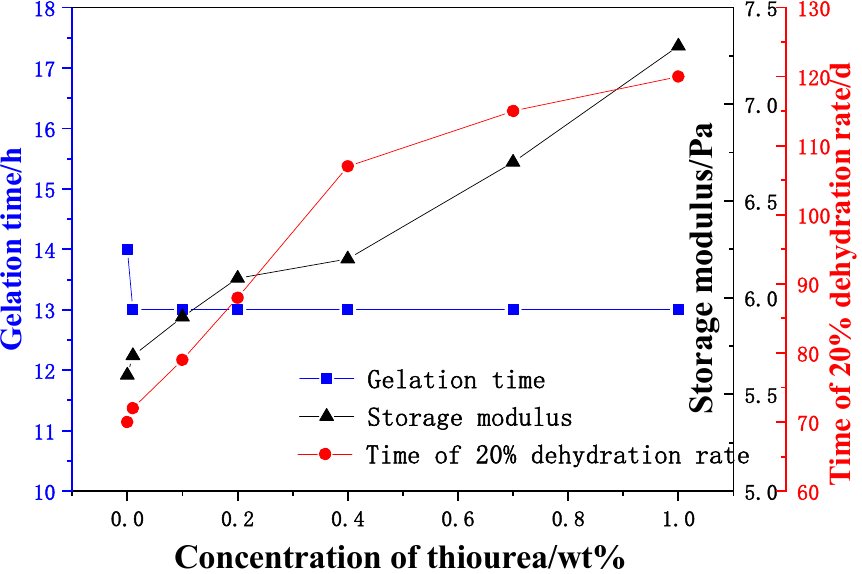
Figure 4. Effect of Thiourea Concentration on Gel Properties.